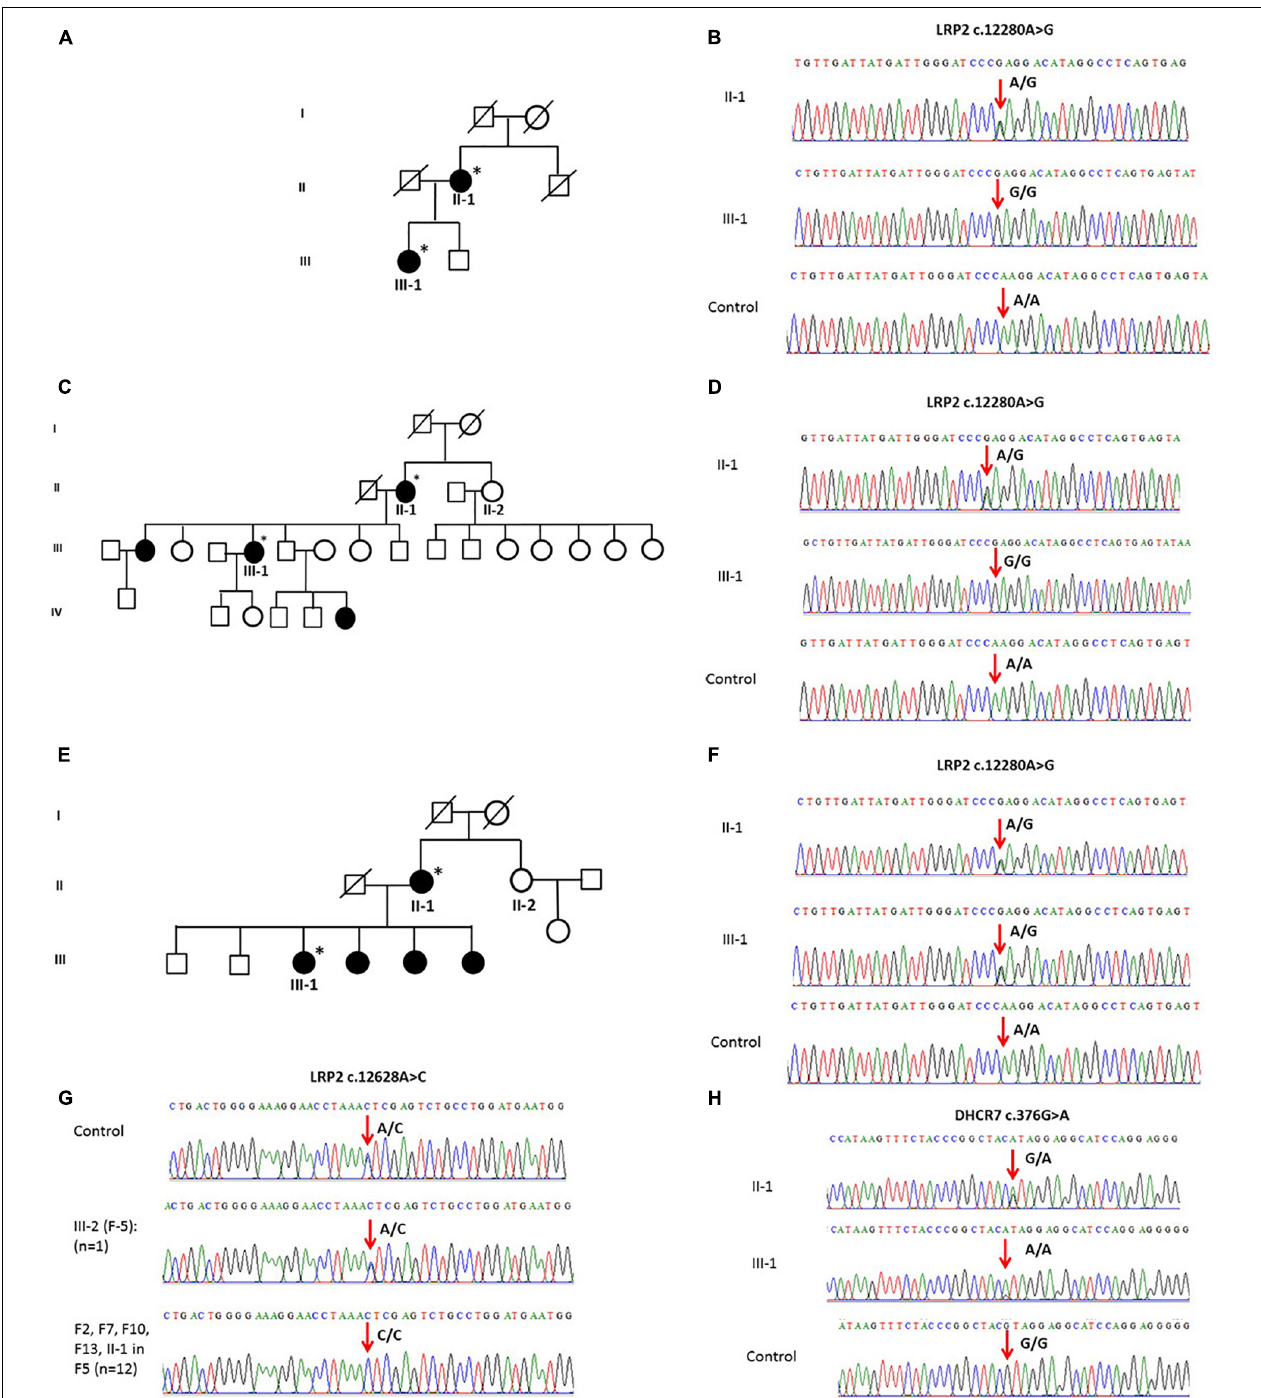
FIGURE 3 | (A) A pedigree of family 1 representing II-1 and III-1 subjects with history of vitD deficiency. (B) Sanger sequencing chromatogram of family 1 showing the c.12280A > G variant in LRP2 with heterozygous AG genotype in subject II-1, homozygous GG genotype in III-1 subject, and homozygous AA genotype in control. (C) A multi-generation pedigree for family 9 showing the analyzed samples with vitD deficiency (the mother II-1 and daughter III-1). (D) Sanger sequencing chromatograms for c.12280 > C LRP2 variants in control (AA), mother (AG), and daughter (GG). (E) A multi-generation pedigree for family 3 showing the analyzed samples with vitD deficiency (the mother II-1 and daughter III-1). (F) Sanger sequencing chromatograms for c.12280 > C LRP2 variants in control (AA), mother (AG), and daughter (AG). (G) Examples of Sanger sequencing chromatograms representing the variant c.12628A > C in the LRP2 gene. Majority of samples ( n = 12) were homozygous (CC), while control samples ( n = 100) and a single sample in F5 were heterozygous. (H) Sanger sequencing chromatogram showing c.376G > A mutation in the DHCR7 gene as (G/A) in mother and (A/A) in daughter compared to control (G/G). ∗ Samples